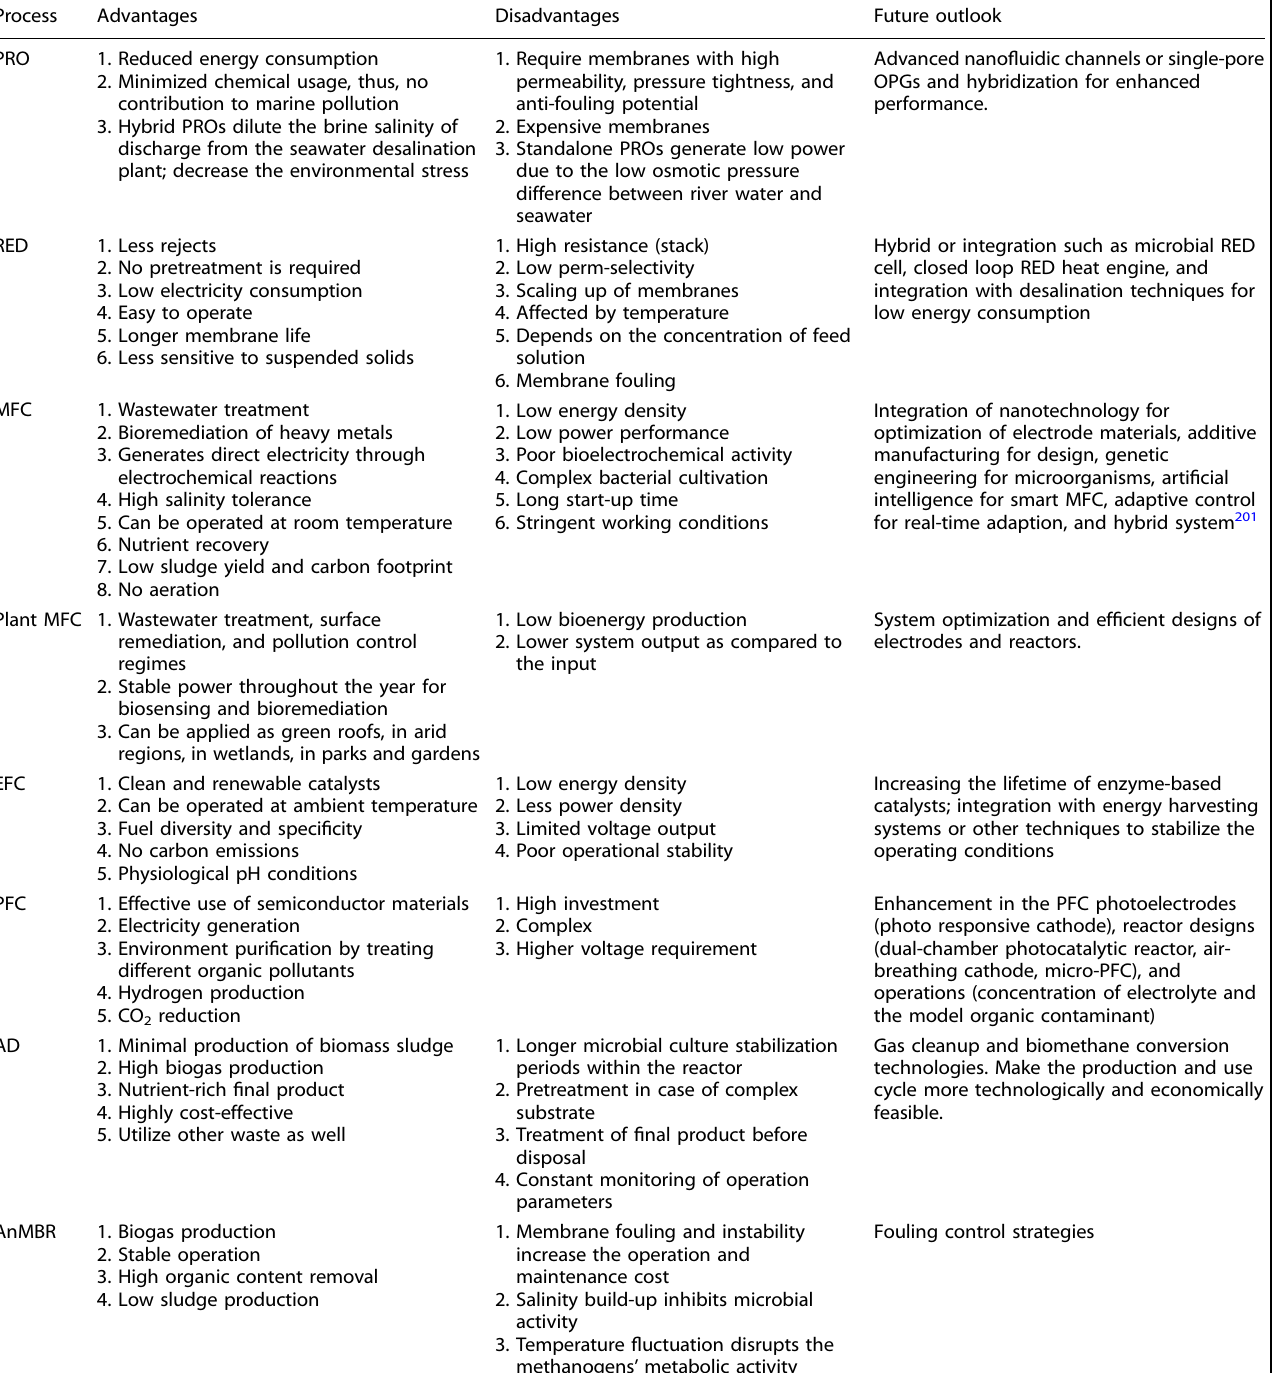
Table 5. Advantages and drawbacks of the (waste)water treatment techniques. Process